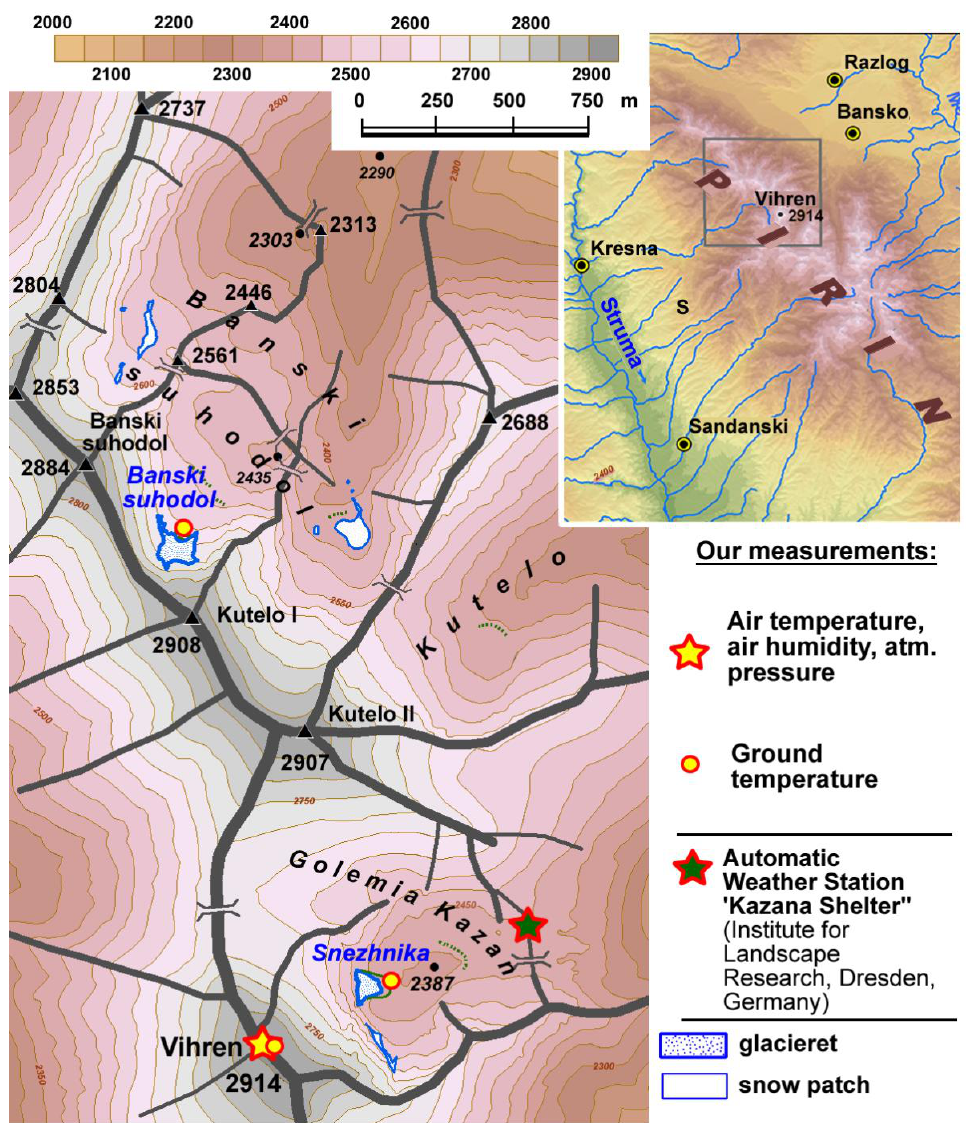
Figure 1. Small glaciers (glacierets) in the Northern Pirin Mountains: Snezhnika and Banski suhodol, and sites for stationary climatic measurements.